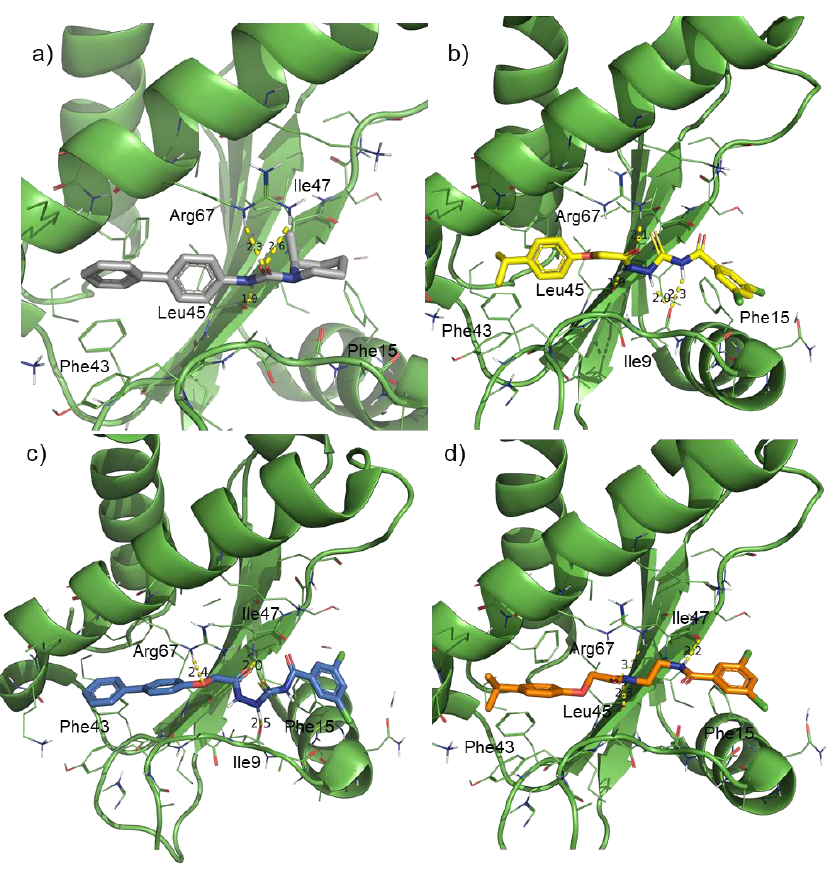
Figure 4. Predicted binding poses, based on docking studies, for different compounds designed in this work: ( a ) Compound 1 (light grey) docked in the putative binding site containing a biphenyl scaffold being the amide able to interact via H-bond with Leu45 and Arg67. ( b ) Compound 6 (yellow) where the carbonyl interacts with Arg67 and thiosemicarbazide makes H-bond with Ile9 and Leu45. ( c ) Compound 10 (blue) making H-bond interaction with Ile9 and Ile47, and Arg67. ( d ) Compound 11 (orange) making H-bond interaction with Leu45, Ile47, and Arg67 with the double amide moiety.